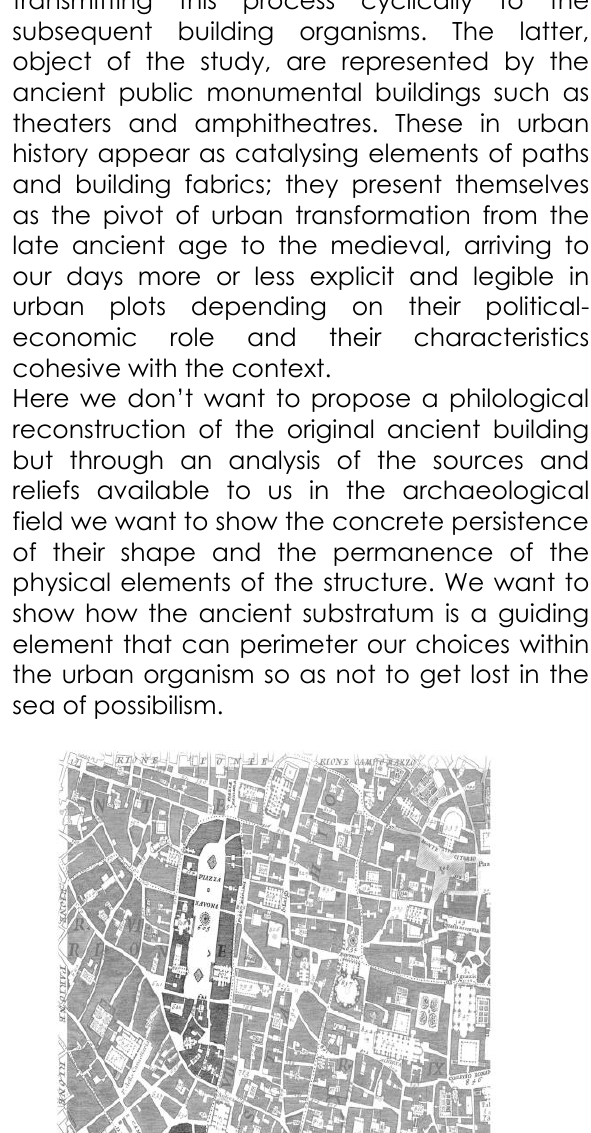
2. The role of the Substrate and the Renaissance district in